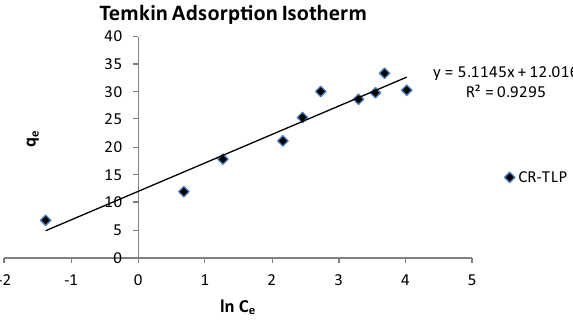
Fig. 16 Temkin adsorption isotherm model. Temperature—30